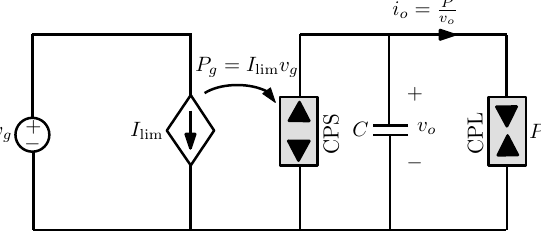
Figure 3. An electrical network loaded by a